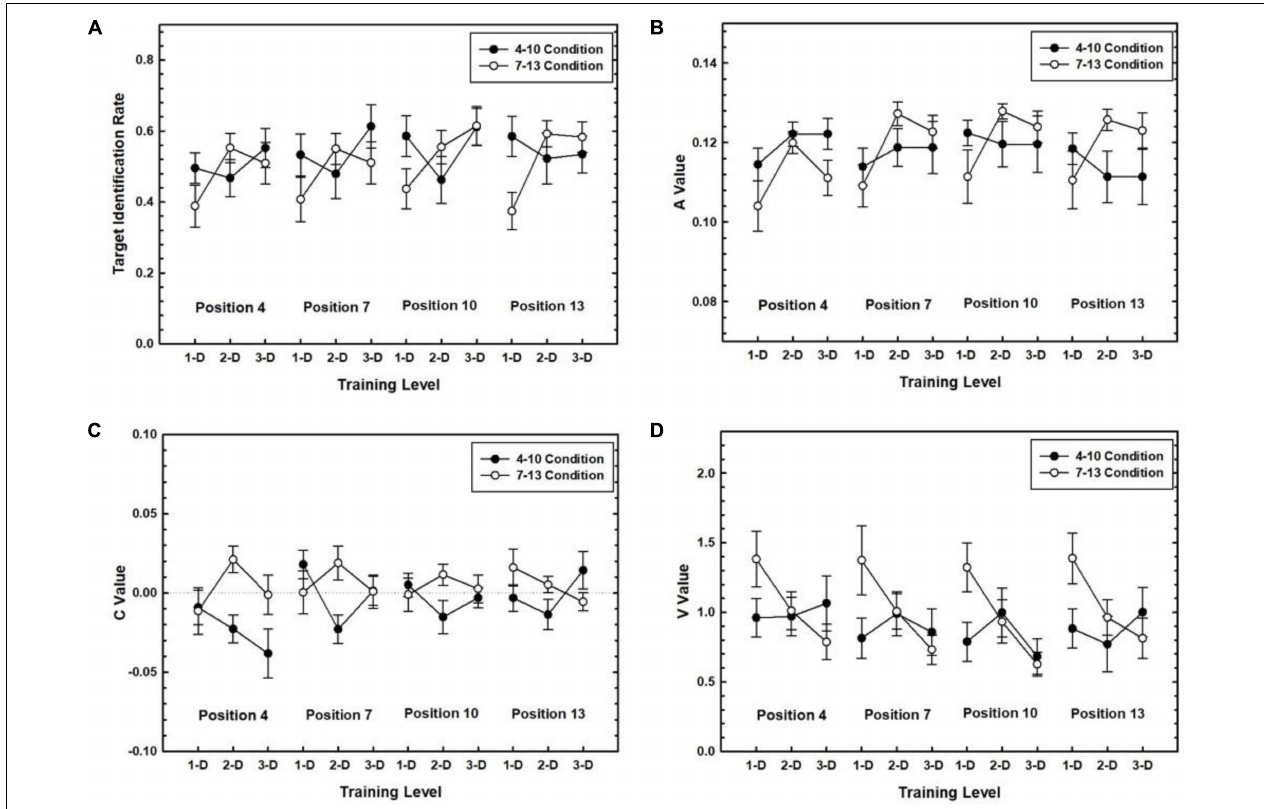
FIGURE 4 | For the 4–10 (A) and 7–13 conditions (B) , the training related Explicit Learning Score (ELS) is plotted as a function of Target Position separately for each Training Level. Error bars represent the SEM.